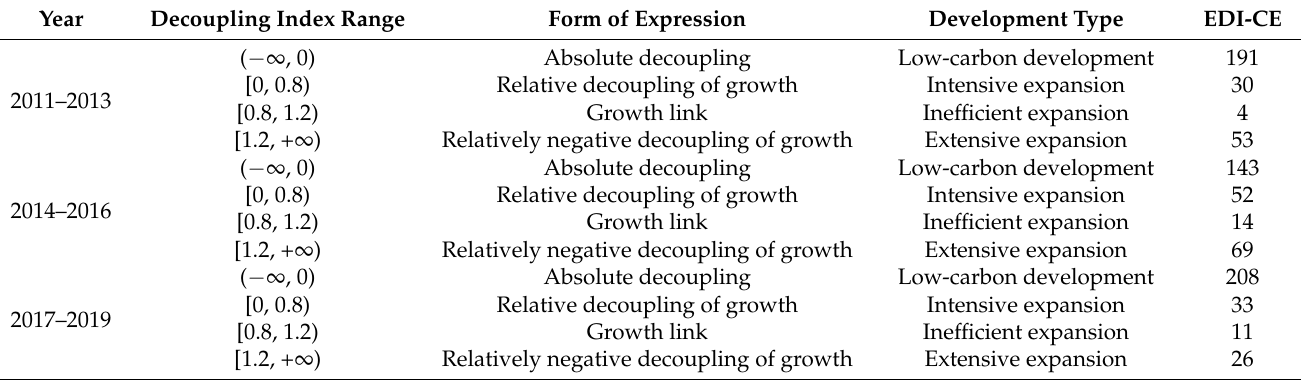
Table 4. Results of decoupling